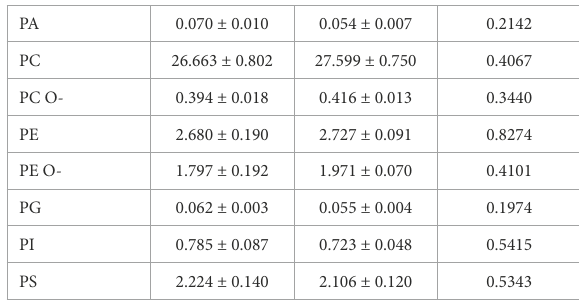
TABLE 1 Lipid classes detected in WT and KO cerebellum.